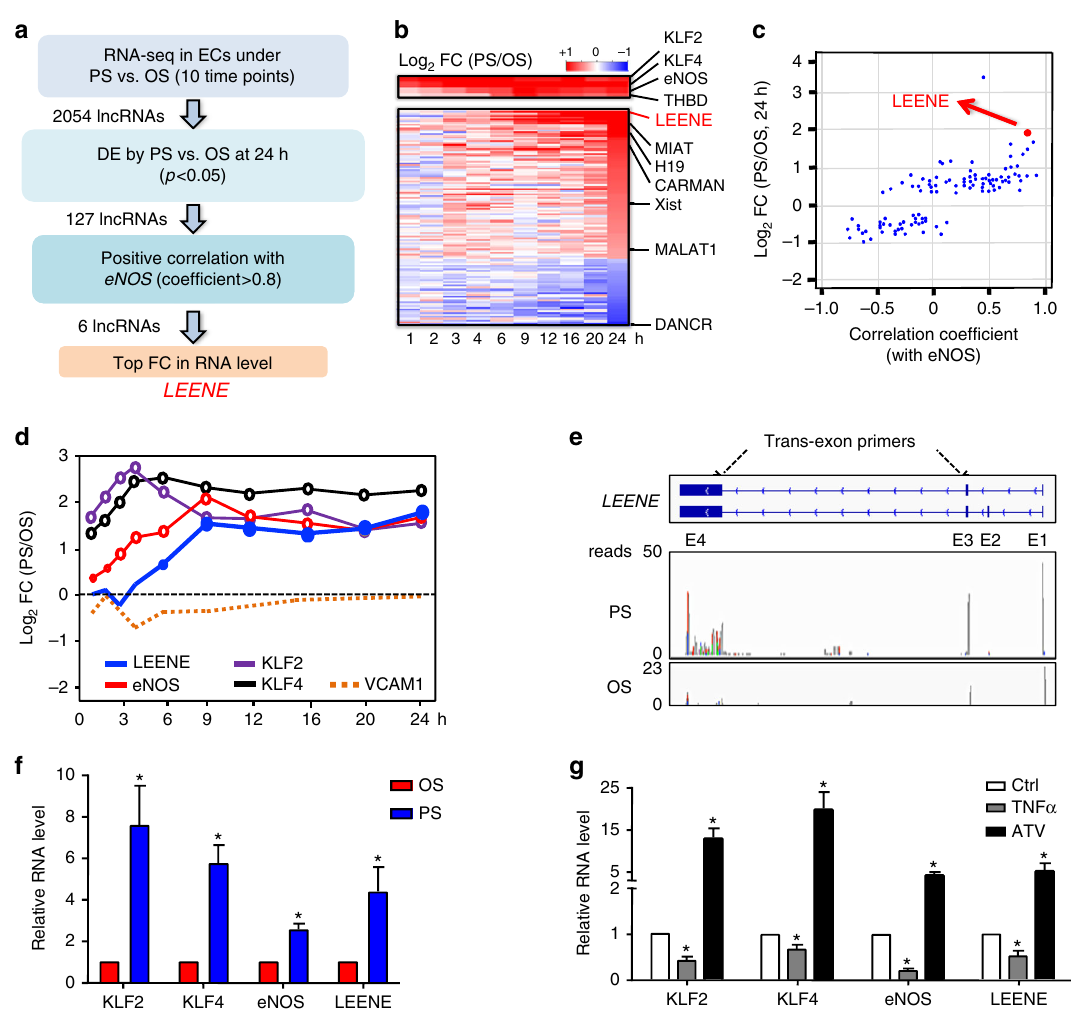
Fig. 1 Co-regulation of LEENE and eNOS. a LEENE discovery pipeline. b Heatmap of RNA levels of fl ow-regulated lncRNAs derived from RNA-seq. c Scatter plot of the fl ow-regulated lncRNAs ranked by differential expression (DE) fold change (FC) at 24 h (PS/OS) and correlation with eNOS mRNA level. d Time course of log 2 FC of mRNAs encoding various genes. e Structure of LEENE gene encoding two RNA transcripts. Trans-exon primers used in qPCR were designed to amplify fragments fl anking Exons 3 and 4. RNA-seq tracks depicting abundance of LEENE in ECs under PS or OS for 24 h. f , g qPCR detection of various RNA transcripts in ECs subjected to PS or OS (in f ) or TNF α (100 ng per ml) or atorvastatin (ATV) (1 μ M) (in g ) for 24 h. Data are presented as mean ± SEM, n = 5 in each group. * p < 0.05 compared to OS (in f , based on Student ’ s t test) or ctrl (in g , calculated by ANOVA followed by